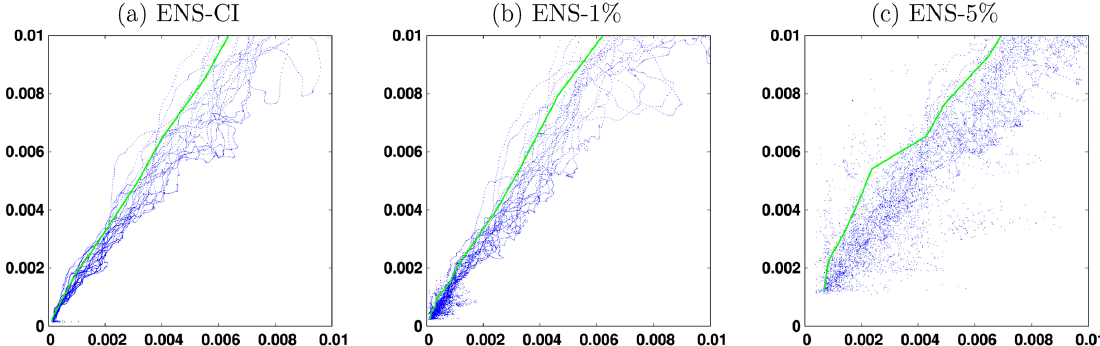
Figure 11. Forecast CRPS score ( y axis) as a function of the initial CRPS score ( x axis) for SSH (meters) at time lag (cid:49)t = 2d. The green line corresponds to the initial score required to have a 95% probability that the final score is below a given value. The figure compares the three simulations (a) ENS-CI (no model uncertainty), (b) ENS-1% (small model uncertainty) and (c) ENS-5% (larger model uncertainty) for the small CRPS scores (smaller than